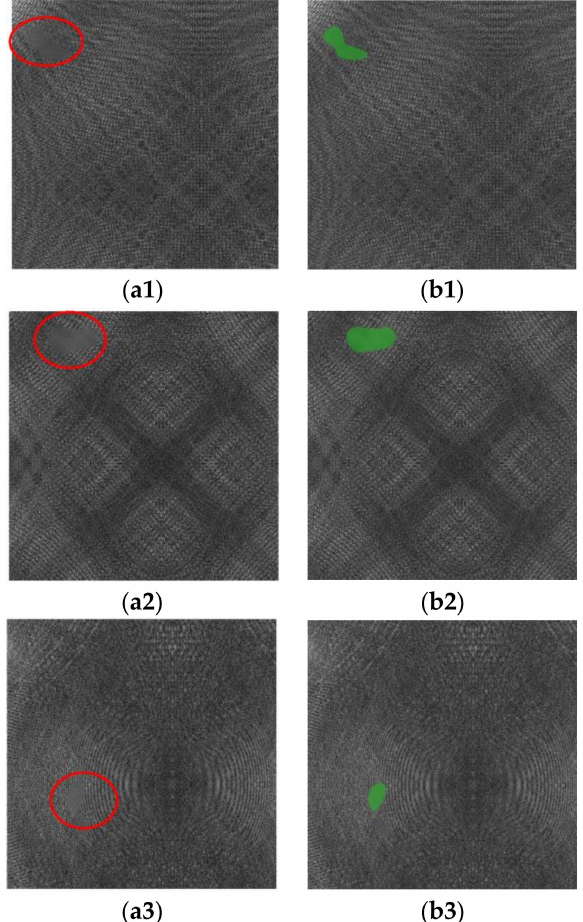
Figure 9. Examples of CASAE-processed images with textured backgrounds. The first columns are examples of ( a1 – a3 ) defects images and ( b1 – b3 ) result images of defects marked in